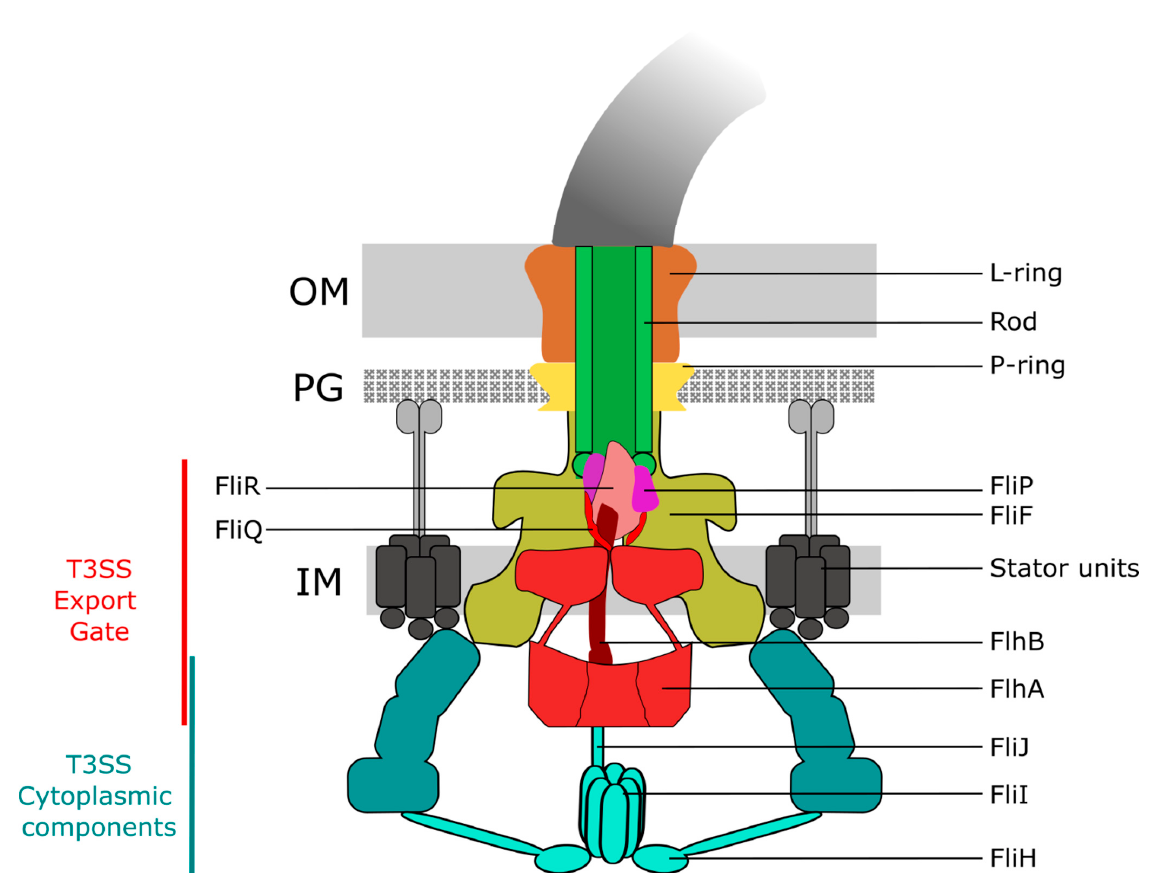
Figure 1. Schematic of the flagellar basal body complex. The basal body consists of the stator units, the periplasmic rod, the P- and L rings embedded in the peptidoglycan (PG) and outer membrane (OM), respectively, the MS ring in the inner membrane (IM), and the T3SS. The T3SS is composed of cytoplasmic components (the C ring and the ATPase complex consisting of FliI, FliH and FliJ), and the export gate (consisting of FliPQR, FlhA and FlhB) located at the base of the basal body within the MS ring.